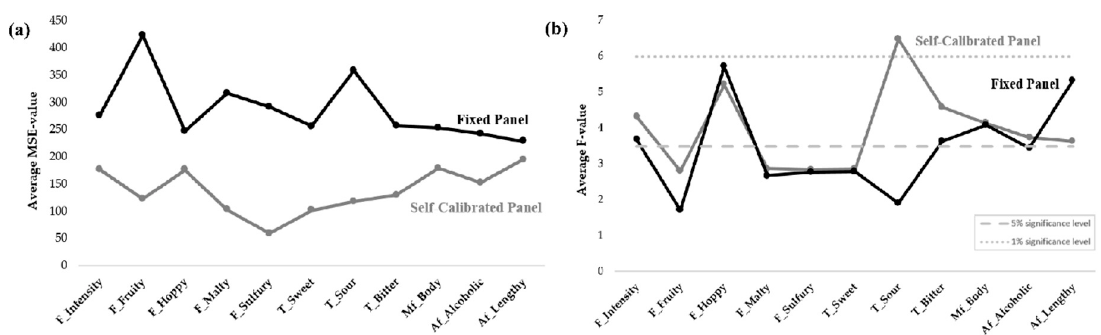
Figure 3. Average ( a ) MSE-values and ( b ) F-values for the two panels. Both plots are averaged over replicate and panelist (F = flavor, T = basic taste, Mf = mouthfeel, Af = aftertaste). The 1% and 5% significance levels are indicated as dotted and dashed lines, respectively.